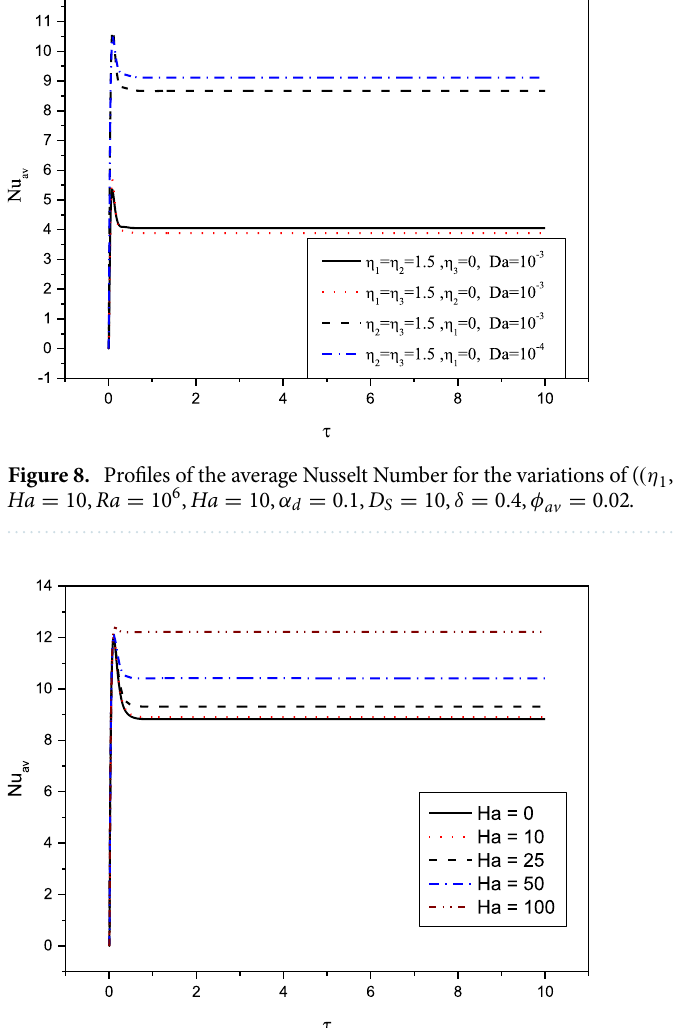
Figure 9. Profiles of the average Nusselt Number for the variations of Ha in case of (η 1 3 , Ra 10 10 6 , δ 0.4, α 0.1, D 10, φ 0.02 . Da S = av = − d = = = =